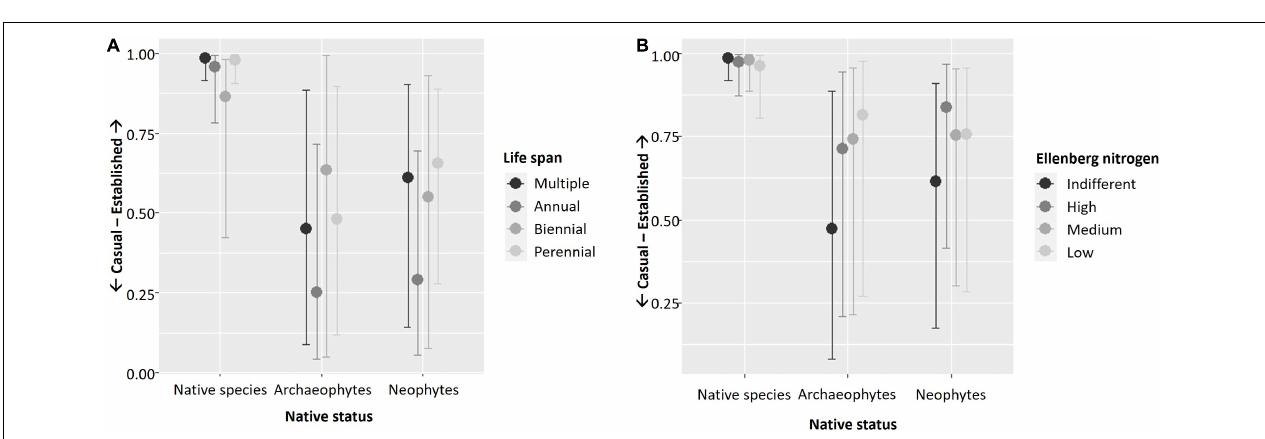
FIGURE 2 | Plots illustrating significant interactions of (A) life span and (B) Ellenberg nitrogen with native status in explaining the establishment of vascular plant species in Berlin, Germany. Results shown are based on the full model (cf. Table 3 ). Y-axes show casual vs. established species as an ordinal response variable and x-axes show the four types of ecosystems. Plots were created using function “conditional_effects.brmsfit” in R-package brms (Bürkner, 2017).